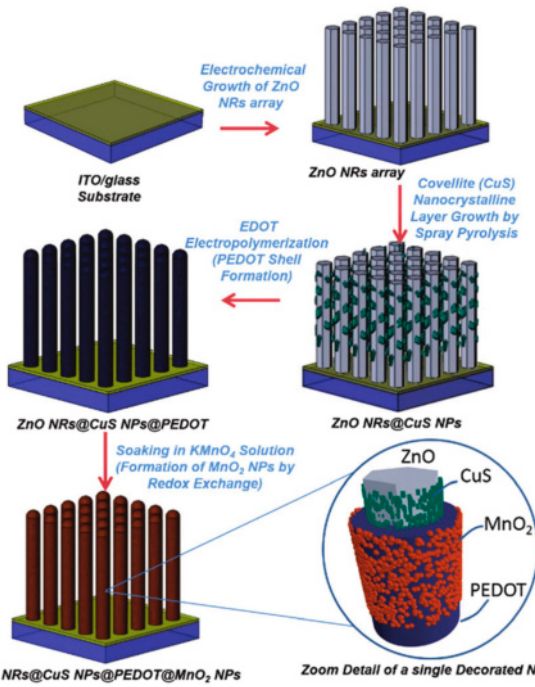
Figure 4. Schematic illustration of formation process of ZnONRs@CuS@PEDOT@MnO 2 hybrid nanostructured electrode [49]. Copyright 2014, the Royal Society of Chemistry.